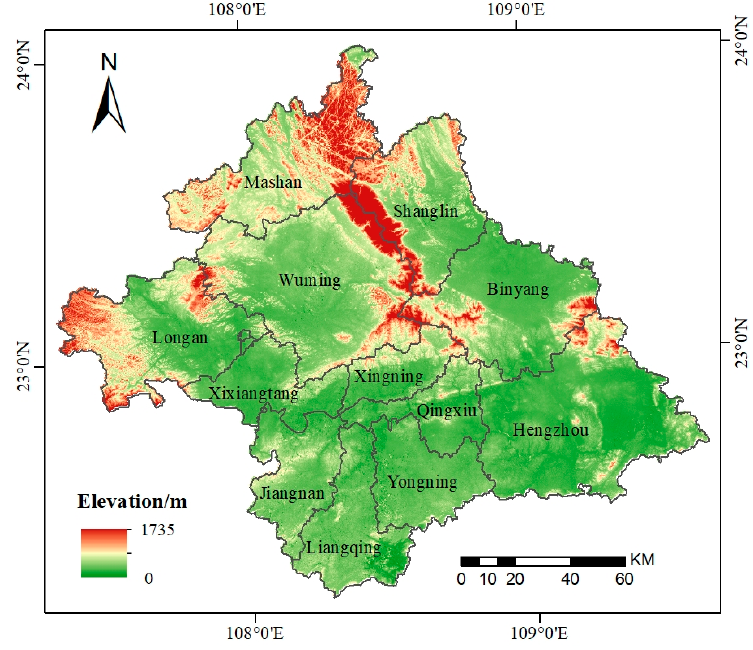
Figure 1. Elevation of Nanning.